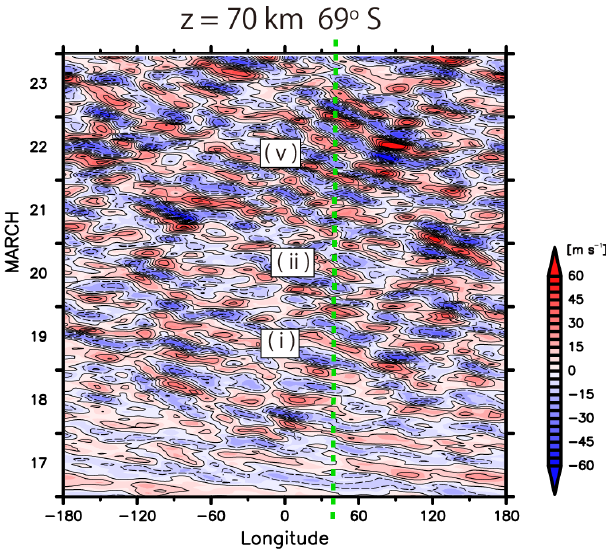
Figure 9. Hovmöller diagram of zonal wind components of the large-scale inertia–gravity waves simulated by NICAM at the height of 70km at 69 ◦ S (contour interval 10ms − 1 ) . (i), (ii) and (v) indi- cate the packets labeled in Fig.